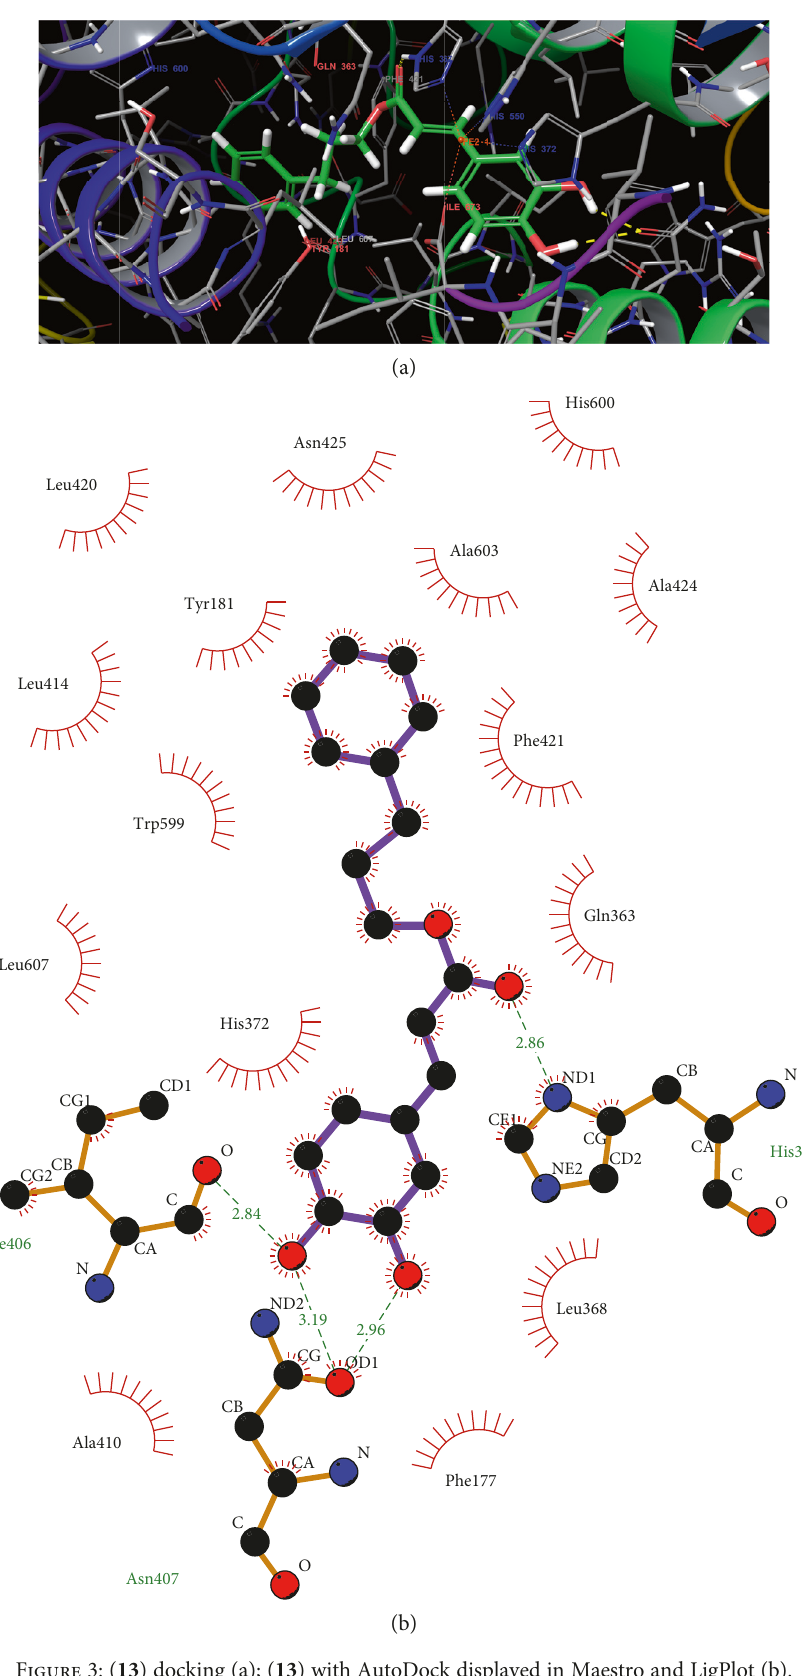
Figure 3: ( 13 ) docking (a); ( 13 ) with AutoDock displayed in Maestro and LigPlot